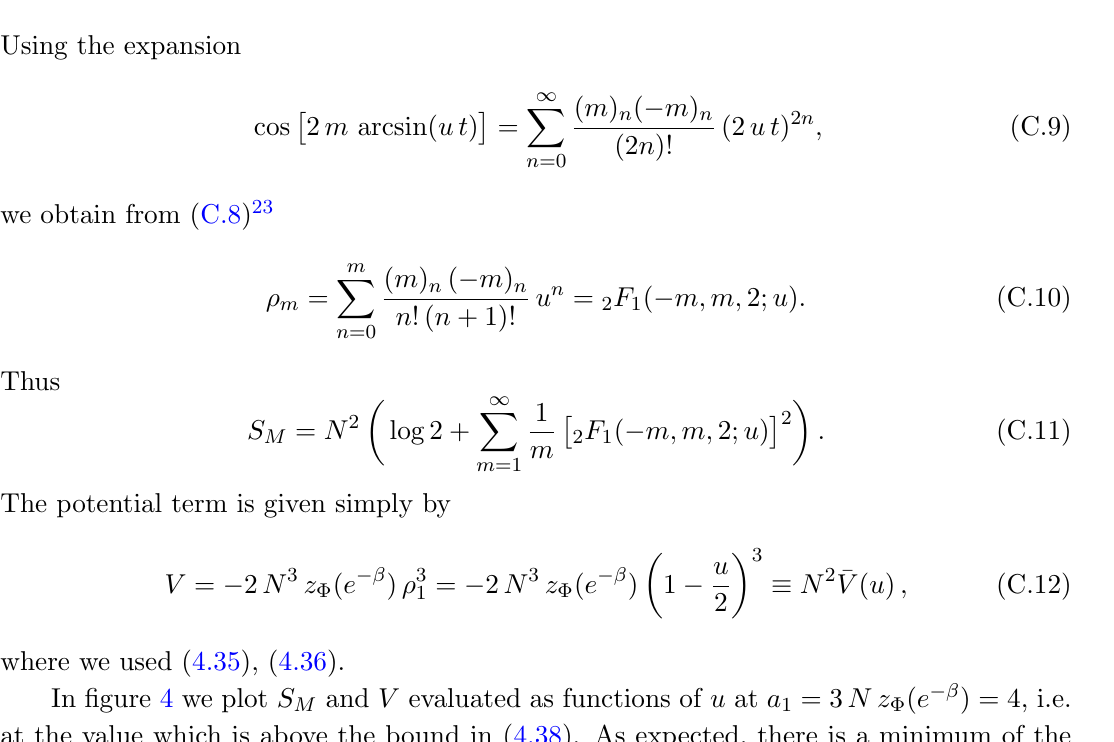
Figure 4 . Plot of the measure term S M in (C.6) and the potential term V in (C.12) in the eigenvalue density action at a 1 = 3 N z (cid:8) ( e (cid:0) (cid:12) ) = 4. The black line is the total action that has a minimum at the position predicted by (4.36), i.e. at u ’ 0 :